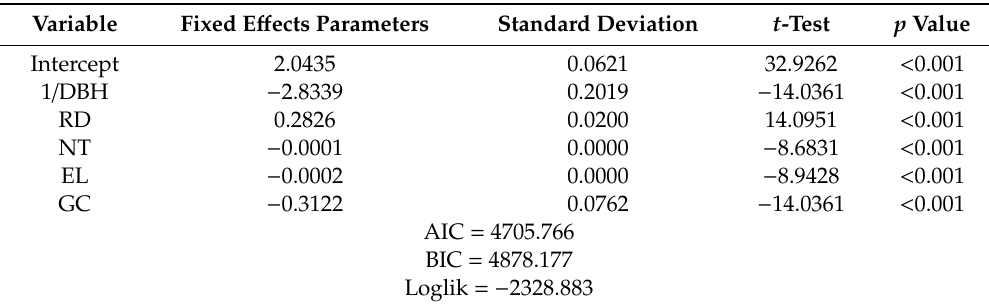
Table 5. Statistical analysis results of variables of the linear mixed-e ff ects individual-tree basal area increment model for oaks.